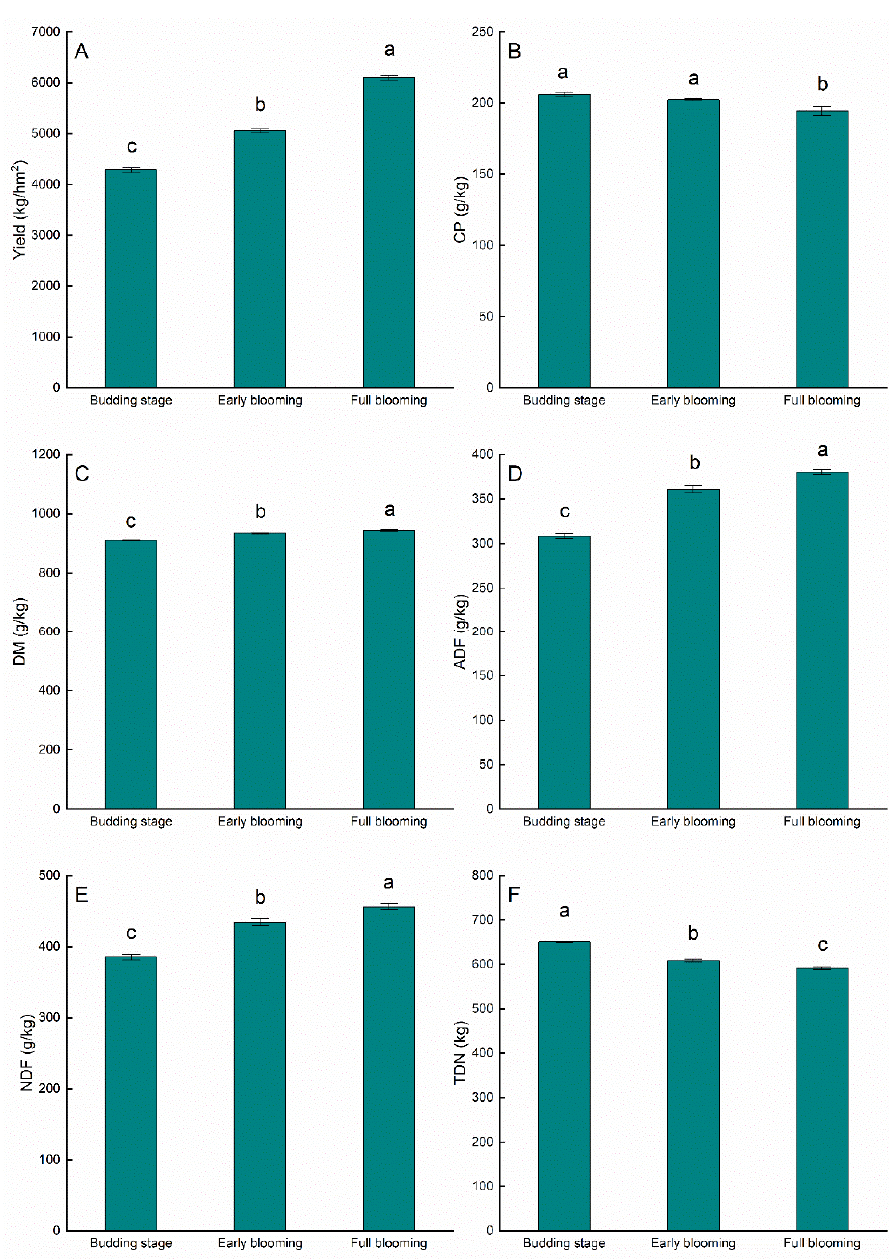
Figure 4. The effects of harvest period on nutritional quality of alfalfa ( A – F ). ( A ) yield, ( B ) crude protein (CP), ( C ) dry matter (DM), ( D ) acid detergent fiber (ADF), ( E ) neutral detergent fiber (NDF), ( F ) total digestible nutrients (TDN). Bars indicate standard error of the means. Different lowercase letters indicate significant difference at p <